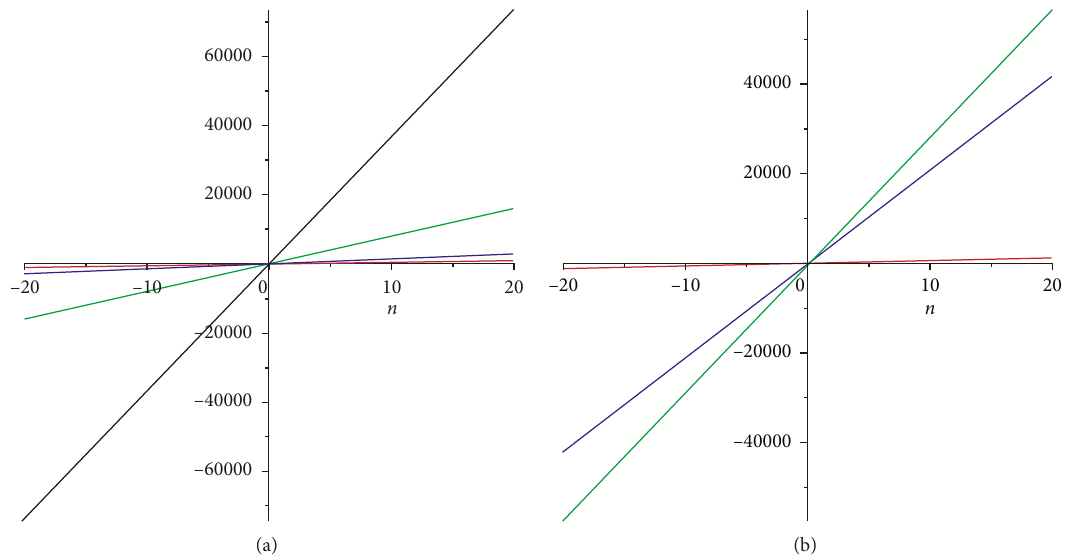
Figure 4: (a) Plot of symmetric division, harmonic, inverse sum, and augmented Zagreb index for fix n parameter. (b) Plot of first Zagreb, second Zagreb, and modified Zagreb index for fix m parameter.